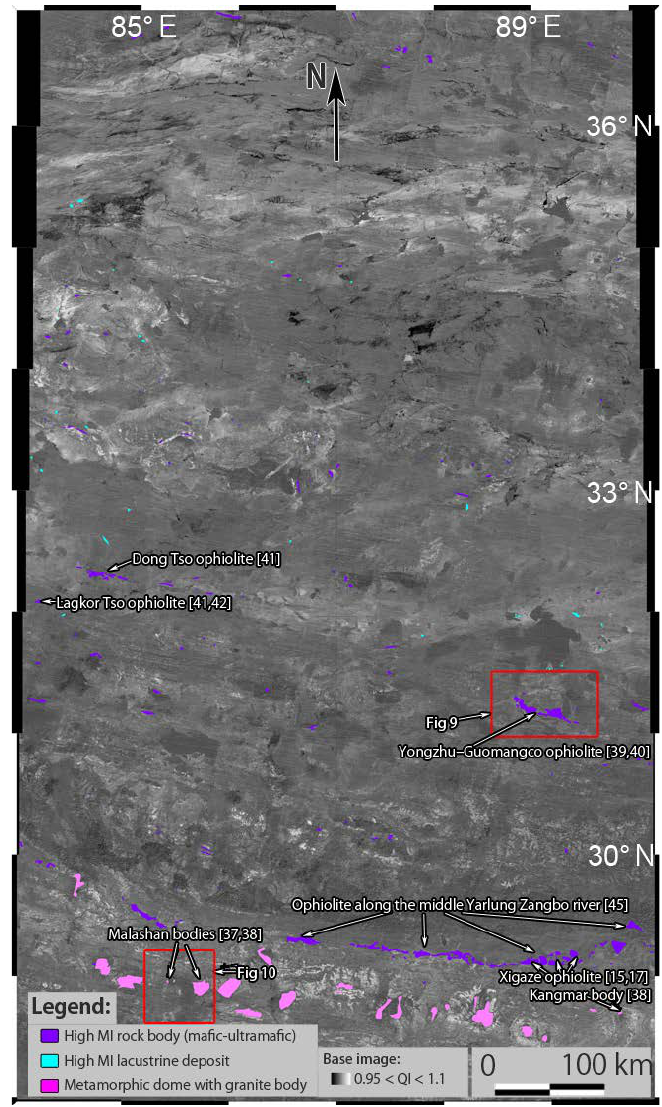
Figure 8. Distribution map for high-MI mafic-ultramafic rock bodies, high-MI lacustrine deposits and metamorphic domes cored with granite, interpreted with the mosaic images of the indices (Figures 4 and 5), VNIR (Figure 2) and the thematic map with the indices (Figure 6) superimposed on the grayscale image of QI. The red rectangles represent the coverage of Figures 9 and 10, respectively. The information of the previous articles with local geological investigations is embedded as the arrowed lines and